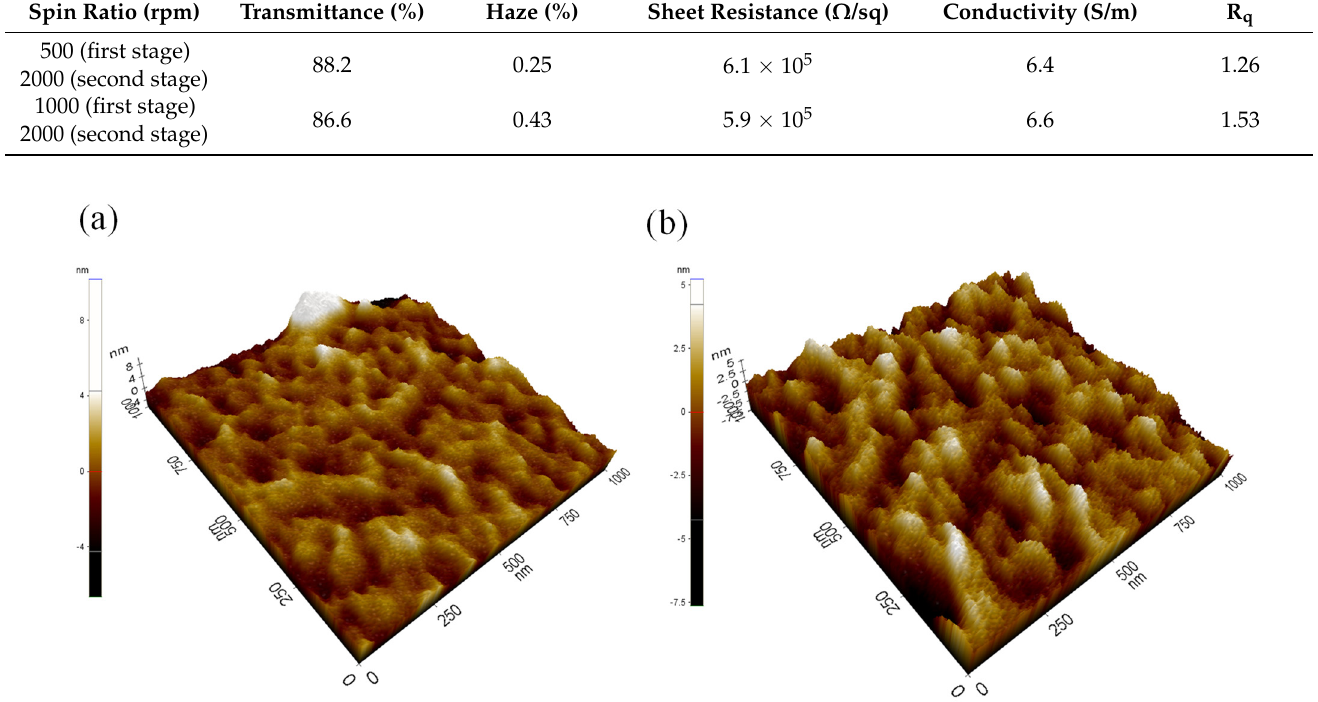
Figure 2. Three-dimensional AFM images of PEDOT: PSS at different pre-coating speeds of ( a ) 500 rpm and ( b ) 1000 rpm. Table 1. Transmittance, haze, sheet resistance, conductivity, and R q of different pre-coating speeds for PEDOT: PSS films.